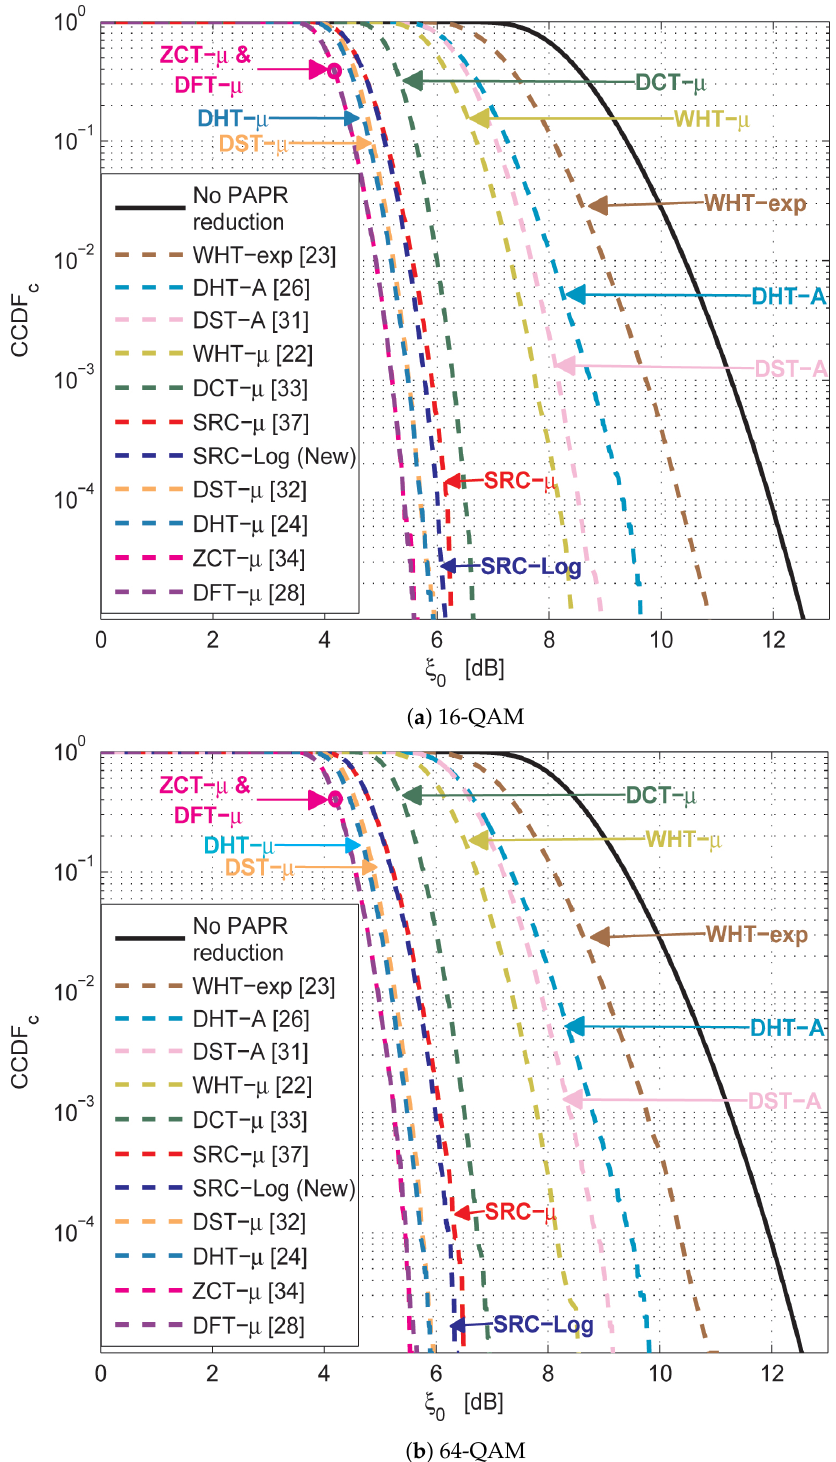
Figure 6. PAPR reduction capability of the new SRC-Log technique and the previous precoding- companding